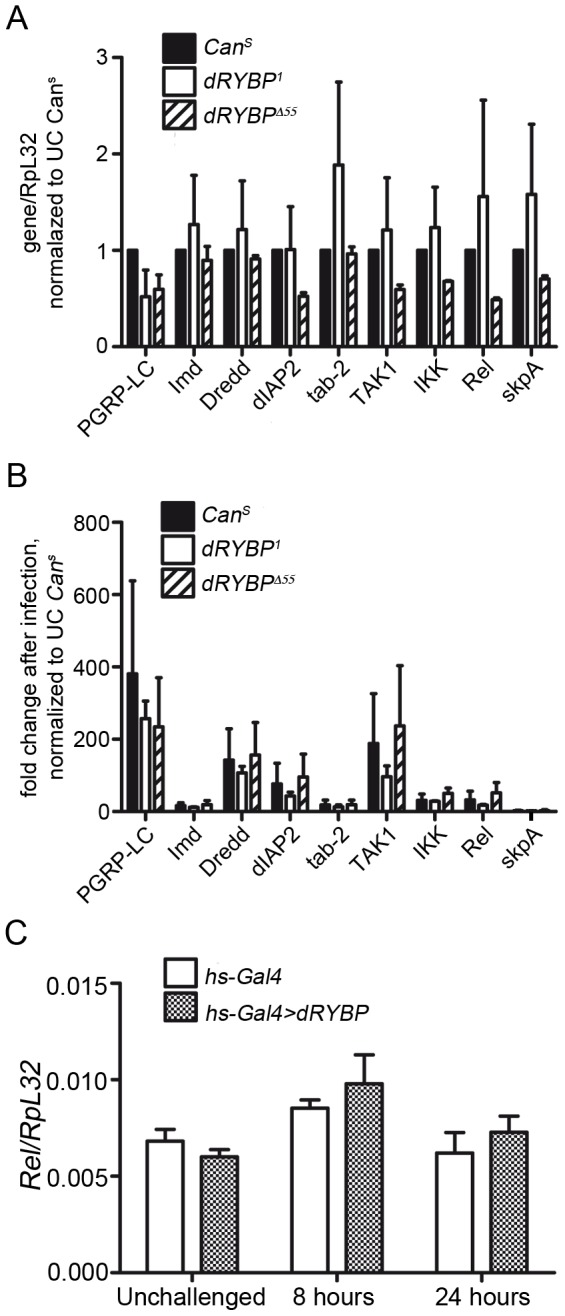
Loss of dRYBP does not affect expression of canonical Imd pathway components.(A) mRNA levels of indicated Imd pathway components were quantified in wild-type and dRYBP mutant flies under unchallenged conditions (A) or (B), 8 h after infection by pricking with Ecc15. Data in (A) and (B) represent mean + SEM of two pooled biological repeats. For each gene, expression is normalized to expression in unchallenged (uc) CanS. No significant difference in gene expression between wild-type and dRYBP mutants, by two-way ANOVA with Bonferroni post-test. (C) Overexpression of dRYBP does not affect Relish expression. Adult females were infected as in (B), then were heat-shocked for 1 h at 37°C and collected at 8 h and 24 h after infection for quantification of mRNA levels of the IMD-dependent transcription factor Relish. Data represent mean + SEM of 3 biological repeats.